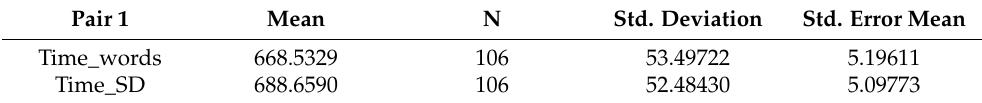
Table 4. Descriptive statistics for reaction time for iconic (SD) and non-iconic words.